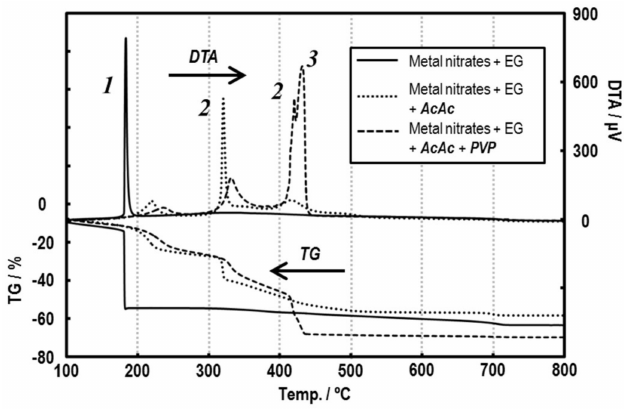
Figure 3. TG–DTA curves of Sm–Fe precursors dried at 120 ◦ C.